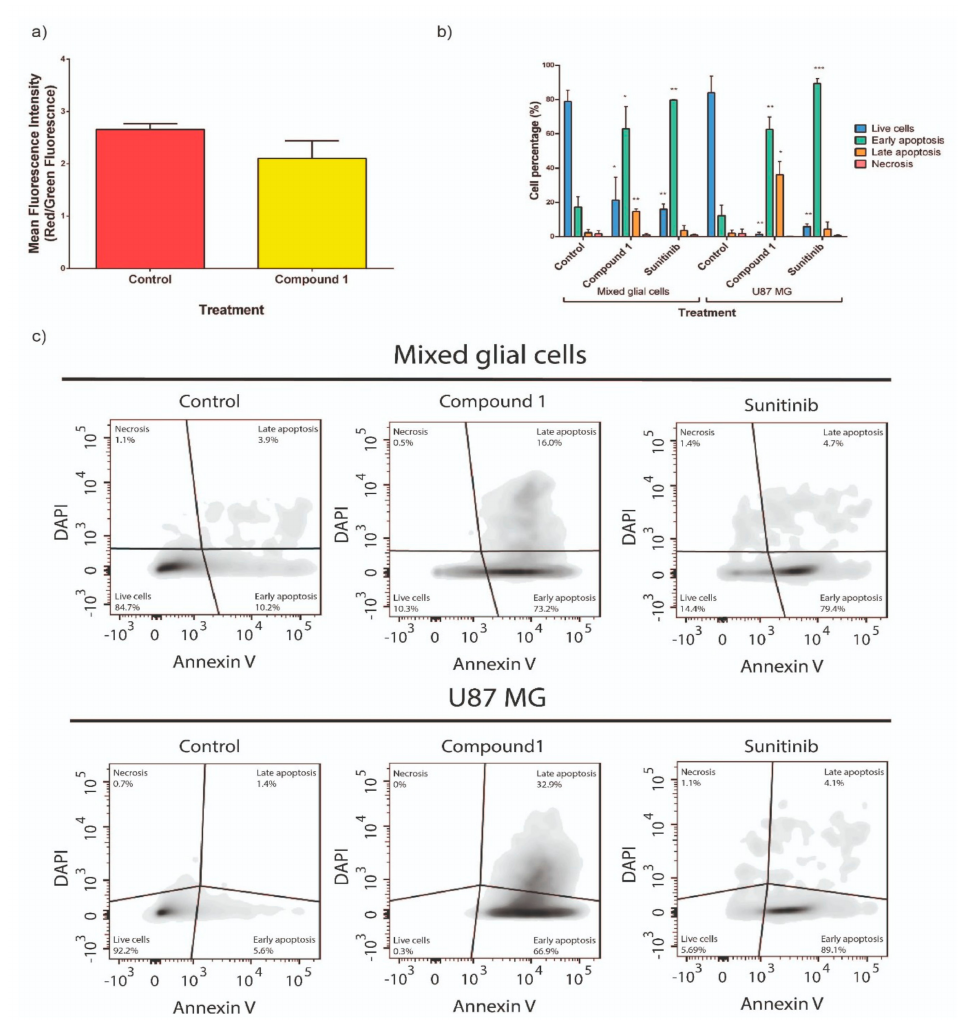
Figure 5. ( a ) Collapse of the mitochondrial membrane potential results for untreated and compound 1 -treated U87 MG cells. Compound 1 was evaluated at IC 50 doses (8.0 ì M) incubated for 4 h. ( b ) Quantitative analysis of flow cytometry results (three independent experiments). (*) p < 0.05; (**) p < 0.01; (***) p < 0.001 when compared to the negative control by two-way analysis of variance (ANOVA). ( c ) Phosphatidylserine exposure results for mixed glial cells (top) and U87 MG (bottom). Compound 1 and Sun were evaluated at their IC 50 doses (8.0 ì M and 32.0 ì M, respectively) after incubation for 24